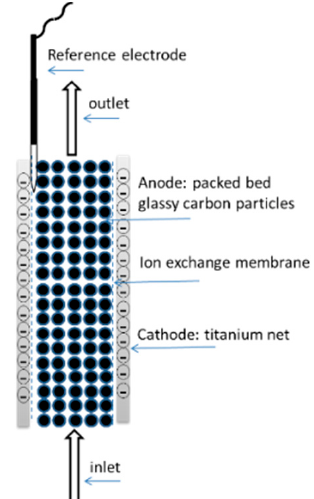
Figure 6. Schematic diagram of the three-dimensional electrode [48] .